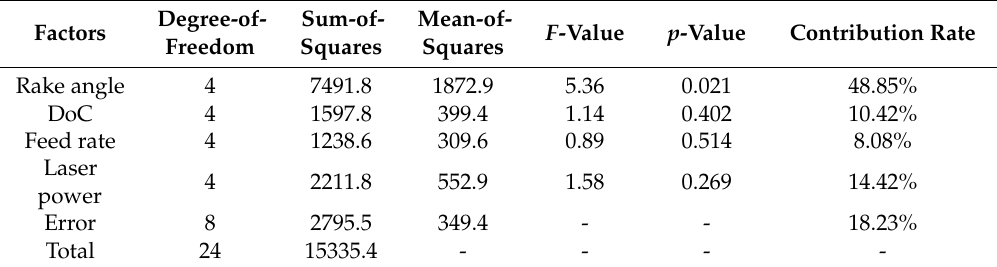
Table 4. Analysis of variance (ANOVA) results from mean surface roughness